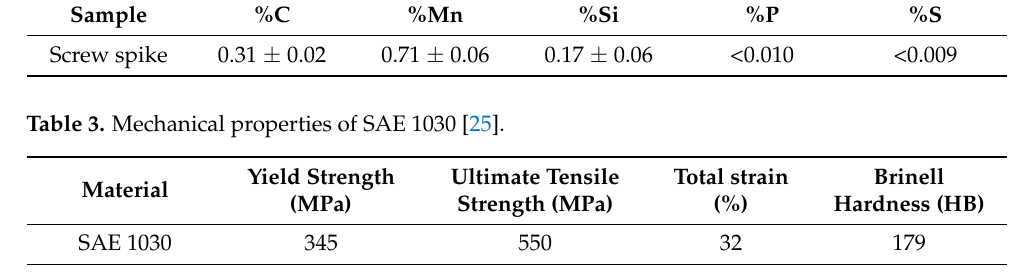
Table 2. Chemical composition of the material of the tested screw spikes.